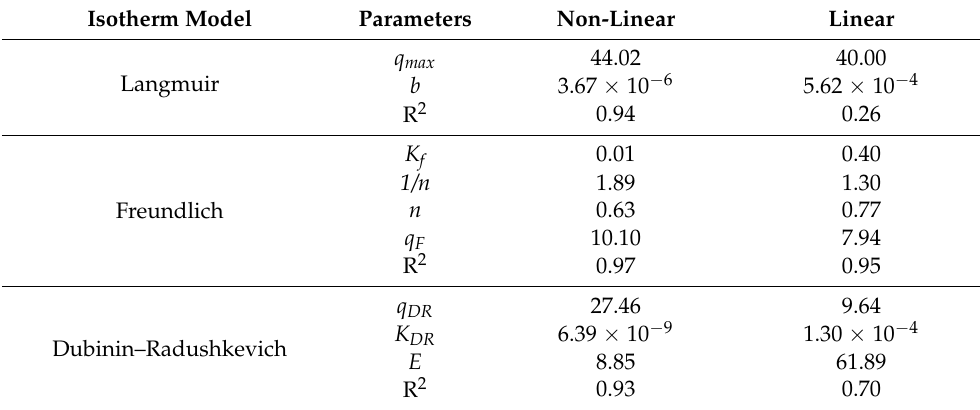
Figure 9. Non-linear modeling of the Cr (VI) adsorption isotherm at pH = 2, 55 ◦ C and 0.14 g of adsorbent. Table 7. Modeling adjustment parameters of the Cr (VI) adsorption isotherm at pH = 2, 55 ◦ C and 0.14 g of